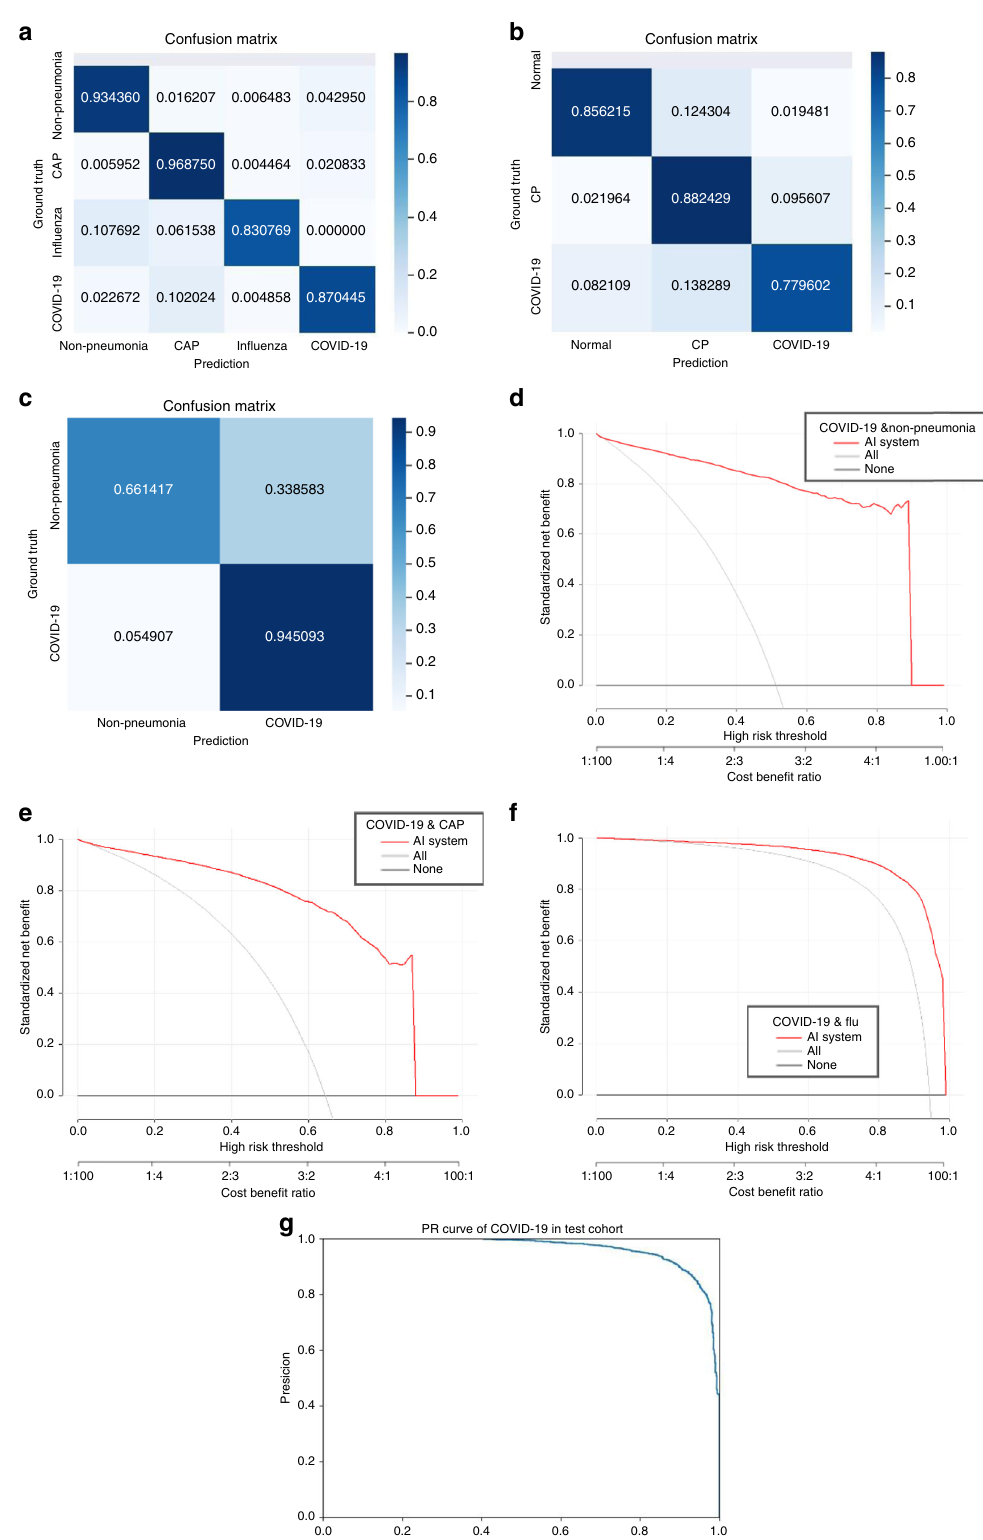
Fig. 3 Performances of the AI system. a Confusion matrix of the four diagnostic categories in the test cohort. b Confusion matrix of the CC-CCII test cohort. c Confusion matrix of the two diagnostic categories in MosMedData cohort. d – f DCA of the AI system in the test cohort for differential diagnosis of COVID-19, non-pneumonia, CAP, and in fl uenza-A/B. g PR curves employed to assess the AI system performance on COVID-19